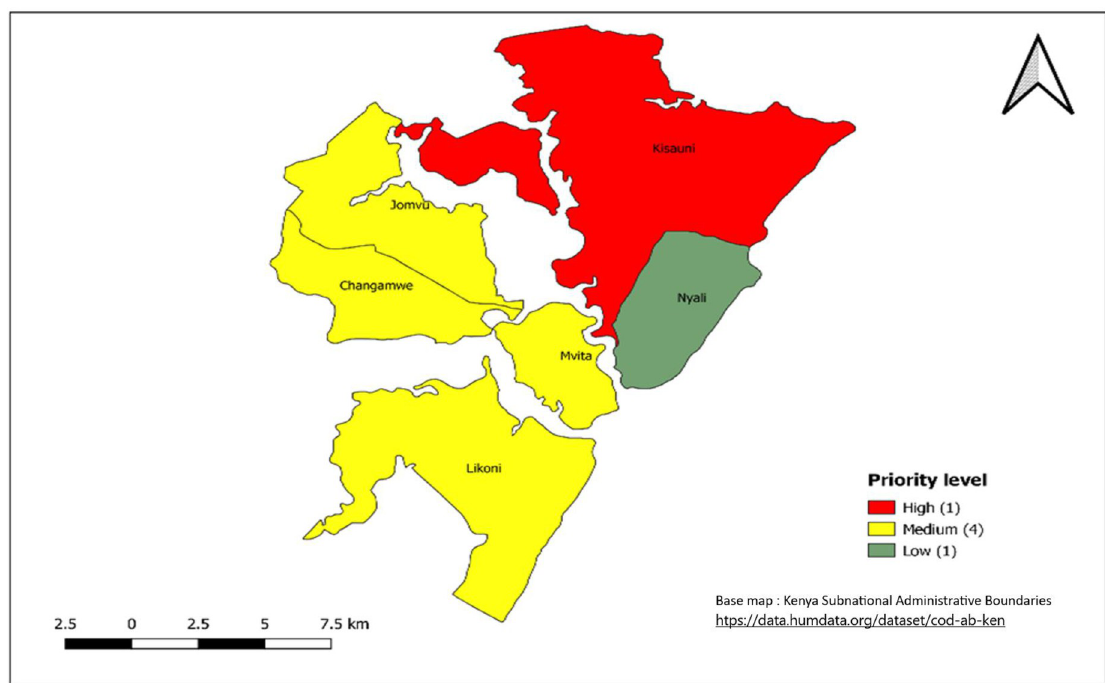
Fig 8. Priority sub-counties in Mombasa County based on a combination of Epidemiological and WASH indicators, 2015–2019. Link to base map layer: https://data.humdata.org/dataset/cod-ab-ken Link to terms of use: https://data.humdata.org/faqs/licenses.